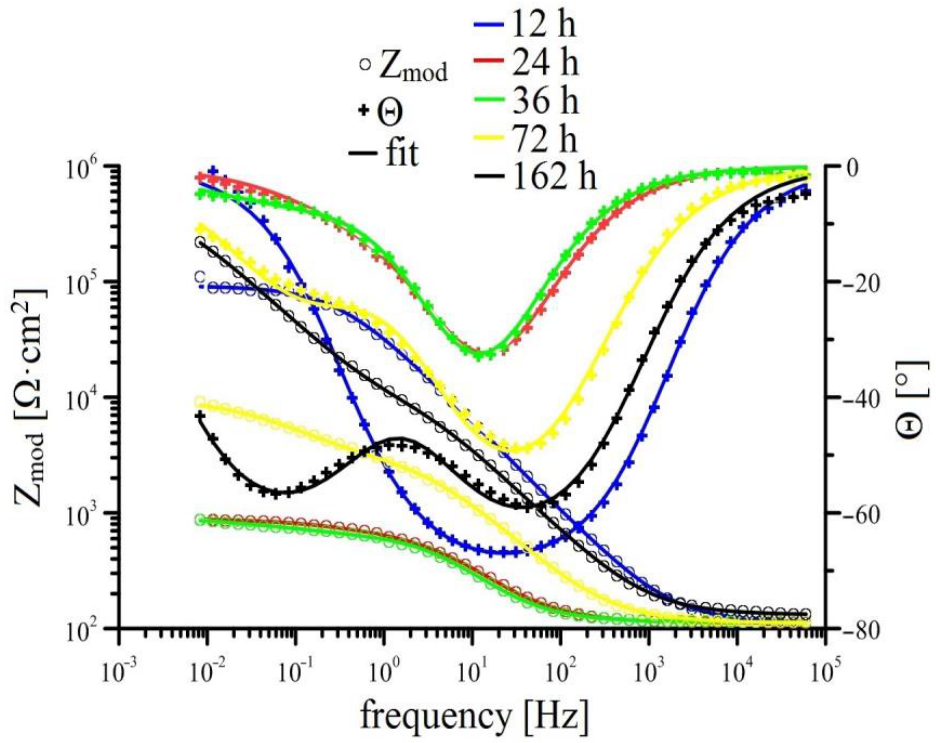
Figure 8. Time-dependent impedance spectra for reference solution (Bode plot: log Z mod vs. log frequency and phase angle vs. log frequency).